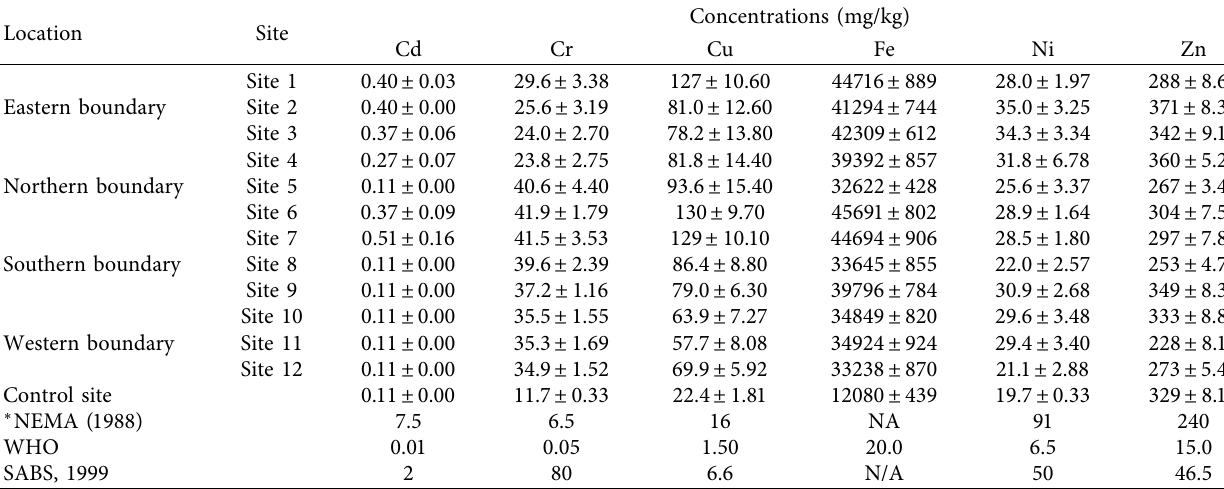
Table 1: Mean concentrations of heavy metals in soils around the landfill at a depth of 0–90cm.